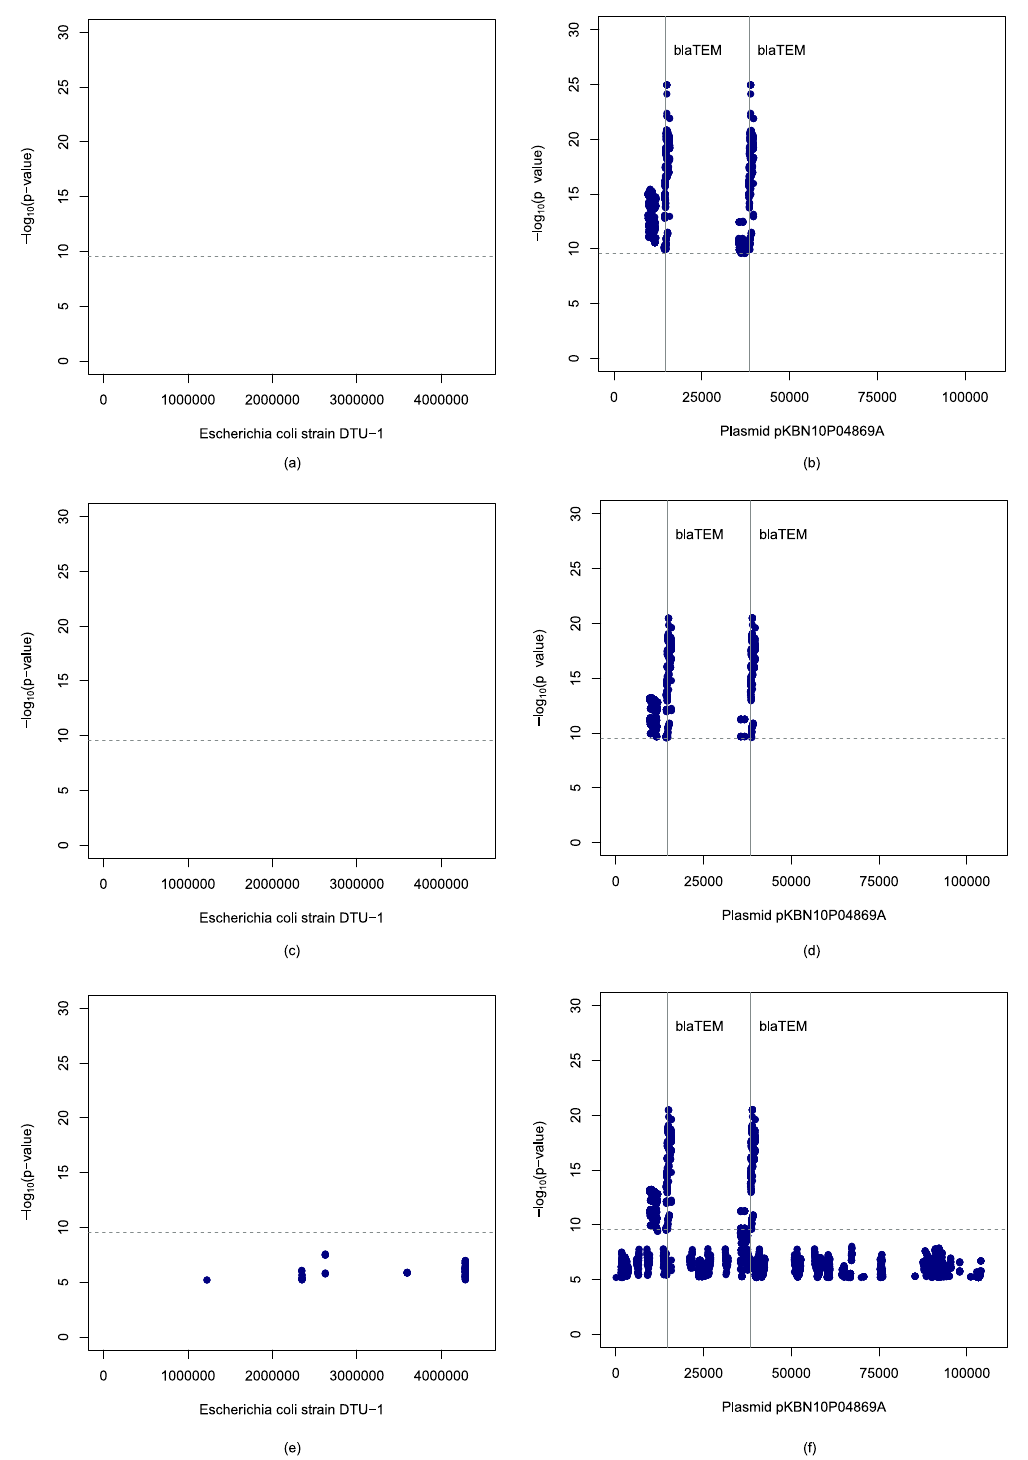
Fig 3. Manhattan plots showing negative logarithms of adjusted p-values of k-mers found significantly associated with ampicillin resistance against their start positions in Escherichia coli strain DTU-1 genome (a), (c), (e), and plasmid pKBN10P04869A sequence (b), (d), (f); computed using the R implementation with Bonferroni correction (a), (b); using the C++ implementation with Bonferroni correction (c), (d); and using the C++ implementation with Benjamini- Hochberg correction with FDR level 0.05 (e), (f). The horizontal lines indicate the threshold for Bonferroni correction at